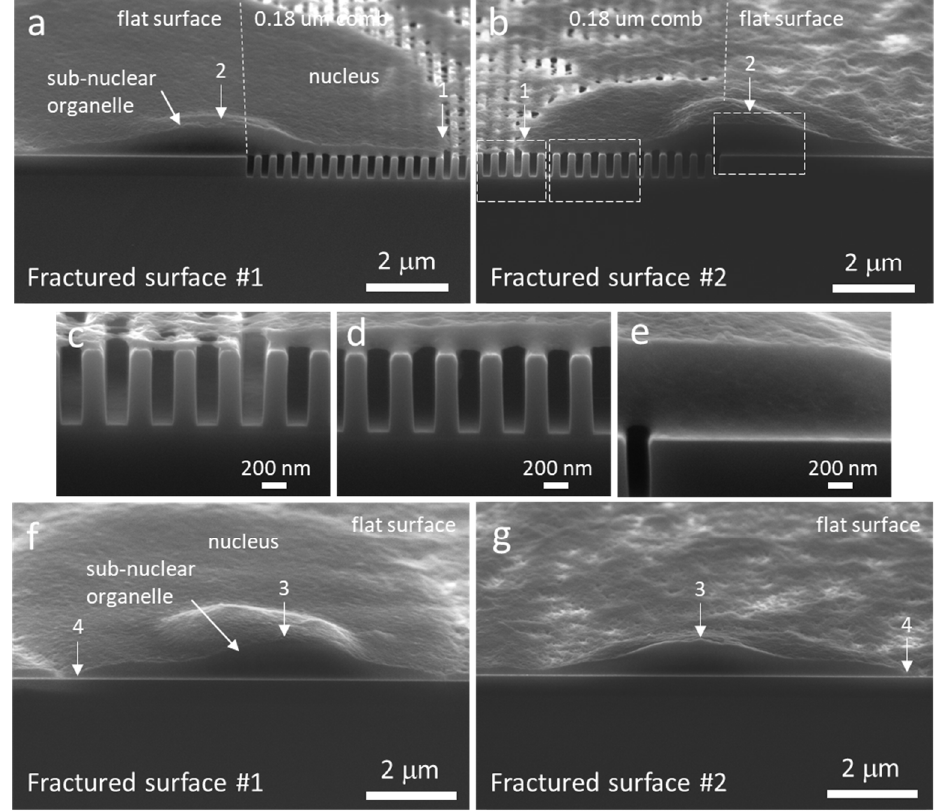
Figure 5. Tilted SEM micrographs of two cross-sectioned cells. ( a – b ) Cell adhered on two types of surface (flat and 0.18 µ m trench pattern). ( c – e ) High magnification images of the fractured surface in ( b ). ( f – g ) Cell adhered solely on a flat surface. Both sides of the cleaved surfaces are displayed in the figure (left and right columns of images). Landmarks “1–“4” are used to match the